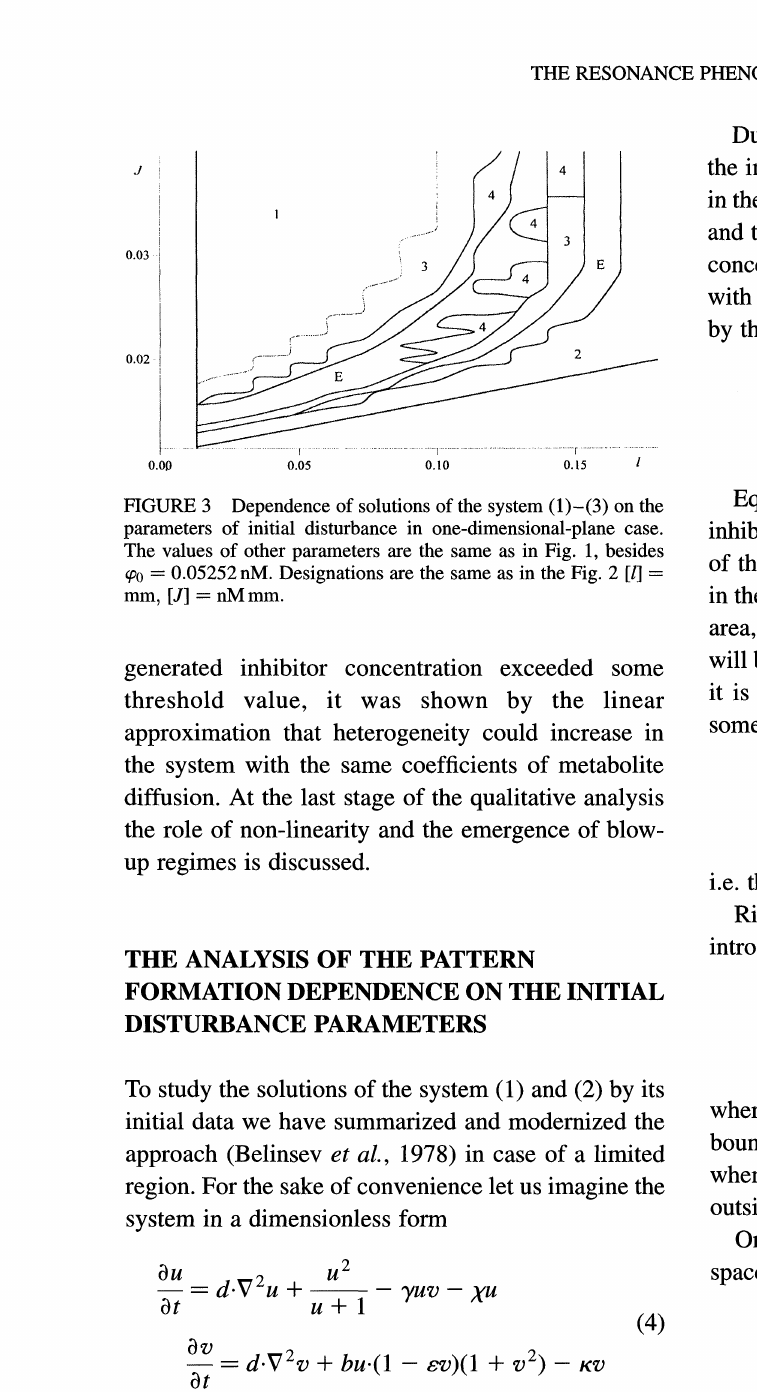
Typical values of dimensionless